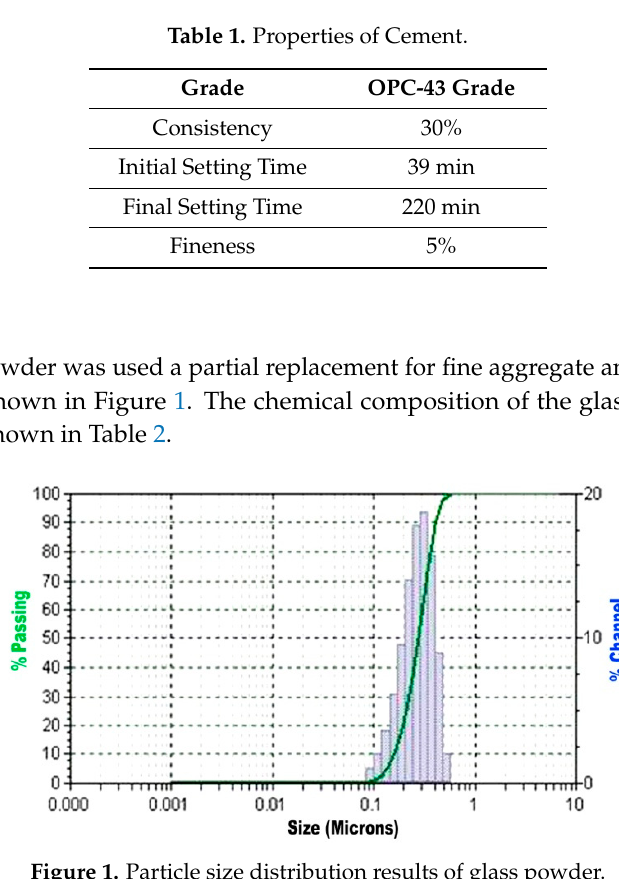
Figure 1. Particle size distribution results of glass powder. Table 2. Chemical Composition (mass %) of Glass Powder (GP).